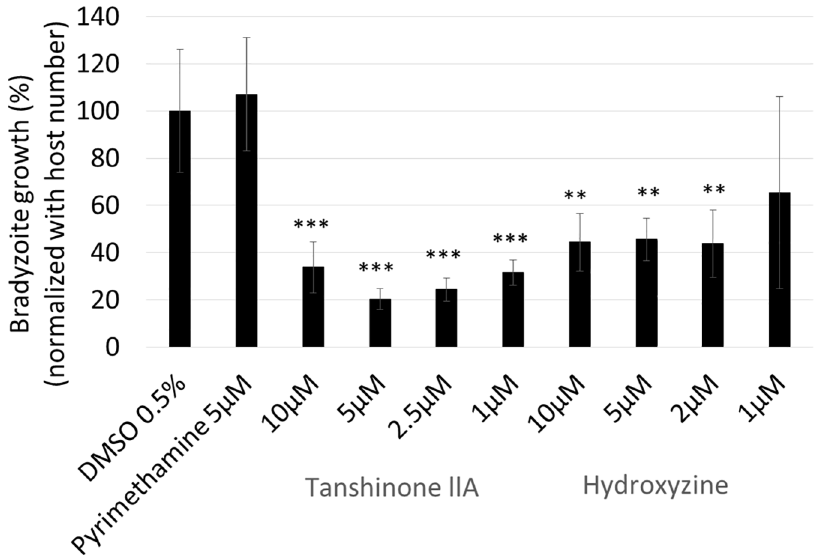
Fig 5. Tanshinone IIA and hydroxyzine reduced the number of in vitro- differentiated bradyzoites. PLK_DLUC_1C9 T . gondii were inoculatedonto a monolayerof HFF cells and incubatedfor 2 h before undergoingbradyzoiteinductionfor 3 days. After bradyzoiteinduction, compounds, as indicated, were added to the medium and infected host cells were incubatedfor 2 days under bradyzoiteculture conditions. Firefly luciferase activity, under the control of the bradyzoite-specific BAG1 promoter, was measuredand normalized to non-treatedcontrol (DMSO) wells. Bradyzoite growth rate was normalized with host cell number. Means ± SD from triplicate wells are shown. The statistical difference betweenthe DMSO control and each compoundwas evaluatedby using Dunnett’stest. ** p < 0.01 and *** p < 0.001.